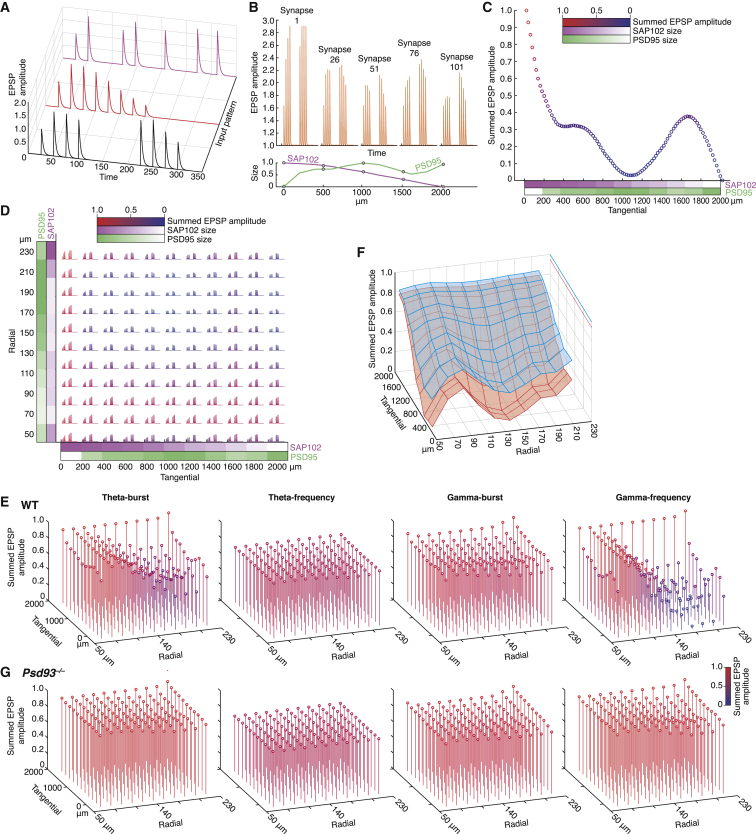
Computational Models of Synaptome Function(A) EPSP amplitude depends on the temporal stimulus pattern. Synaptic responses to theta-burst (black), gamma-frequency (red), and mixed-frequency stimuli (magenta).(B) Differential EPSP responses using hippocampal tangential gradient data. PSD95 and SAP102 size data (bottom) were used to model amplitude parameter values (top). Theta-burst induced EPSP responses over time are shown for five synapses (numbered 1–101) located along the CA1sr tangential axis. Circles in lower graph indicate size values used.(C) Normalized summed EPSP amplitude responses to theta-burst (as in B) shown for 101 synapses along the CA1sr tangential axis. Note regions of strong and weak responses. PSD95 and SAP102 gradients illustrated in the lower graph of (B) are shown here with graded colors (PSD95, green; SAP102, magenta).(D) EPSPs in response to two theta-bursts (as in A–C) in a two-dimensional synaptome map (11 × 11 synapses) derived from tangential (x axis) and radial (y axis) gradients in CA1sr. Normalized sum of EPSP peak amplitudes was color coded from blue (zero) to red (one). PSD95 and SAP102 gradients are shown with graded colors.(E) Normalized summed EPSP peak amplitude responses to different spike input patterns are mapped to different spatial locations and zones in a two-dimensional synaptome map of CA1sr (as in D). Four patterns, each comprising eight pulses, are displayed: theta-burst, theta-frequency, gamma-burst, and gamma-frequency. Amplitudes indicate normalized sum of EPSP amplitudes per synapse.(F) Normalized summed EPSP peak amplitude responses to spike patterns from correct (blue surface) and incorrect (red surface) choice trials are mapped to different spatial locations in a two-dimensional synaptome map of CA1sr (as in D and E). p < 0.05, two-sample Kolmogorov-Smirnov t test. Data are from Kim et al. (2016).(G) Normalized summed EPSP peak amplitude responses to different spike input patterns (as in E) are mapped to different spatial locations and zones in a two-dimensional synaptome map of CA1sr in Psd93−/− mice. Note that the pattern specificity in WT (E) is largely lost, with only a difference in overall amplitude remaining.